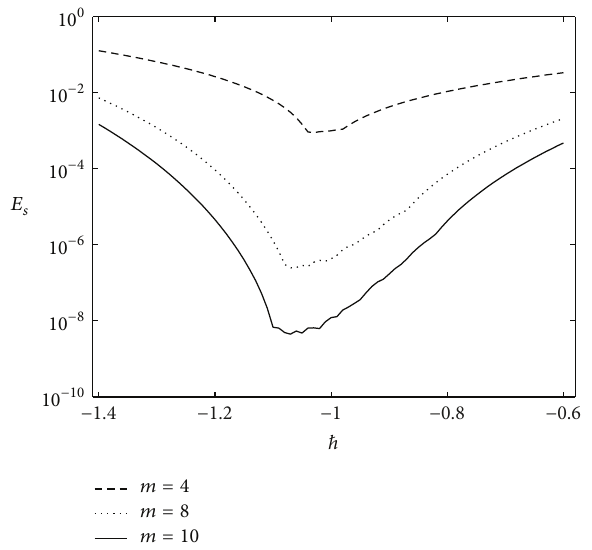
Table3:Maximumerrors 𝐸 𝑁 forFitzhurg-Nagumo’sequationwhen 𝛼 = 1 using ℎ = −0.9 .